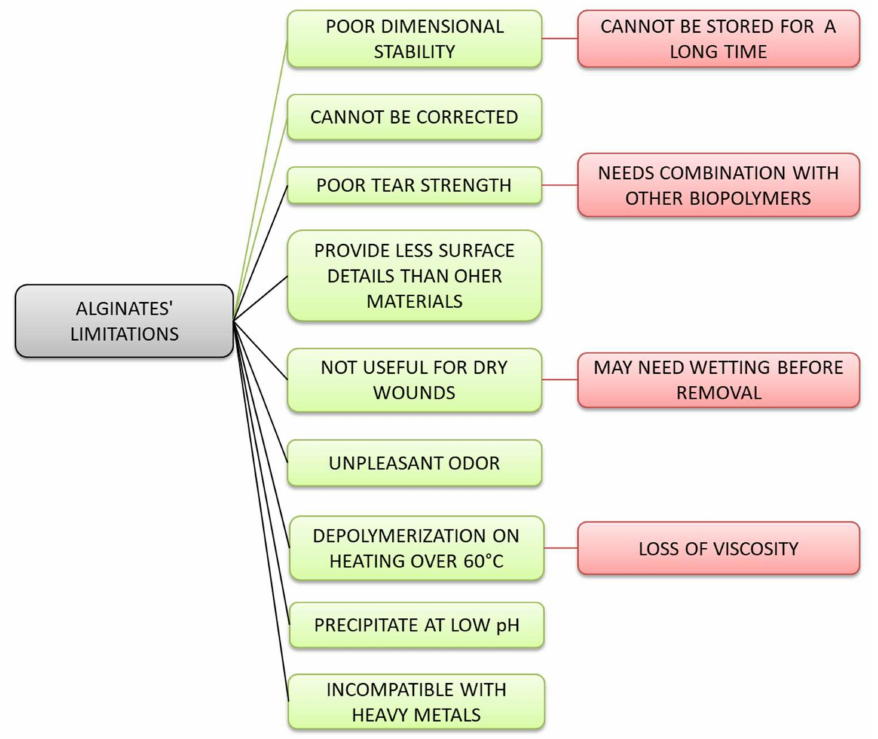
Figure 2. Disadvantages of using alginate in medical